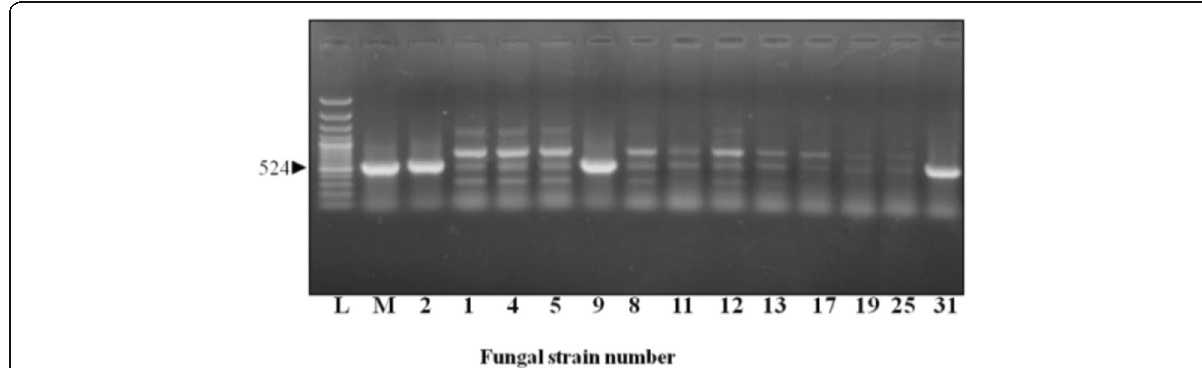
Fig. 2 PCR amplification with Beauveria bassiana -specific primers from different fungal isolates. M is the reference isolate B. bassiana MTCC 2028; L is 100-bp DNA ladder (Fermentas Life